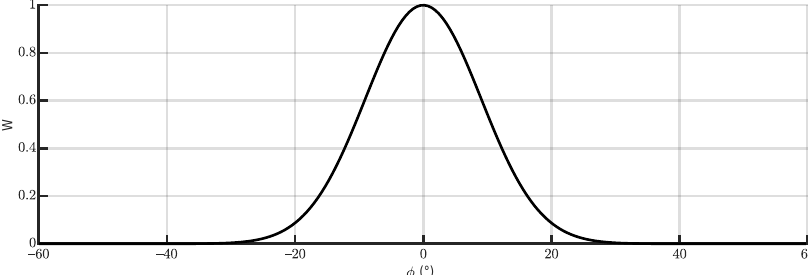
Figure 7. Shape of the weight function used to combine the two estimated measurements of the roll